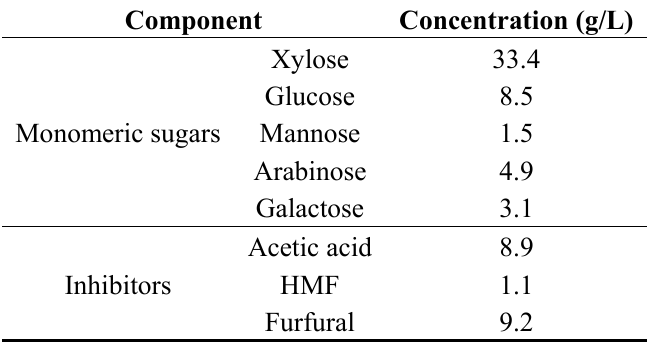
Table 1. Composition of the liquid fraction of the supplied pretreated wheat straw (slurry), used as xylose-rich lignocellulosic biomass with 14.9% suspended